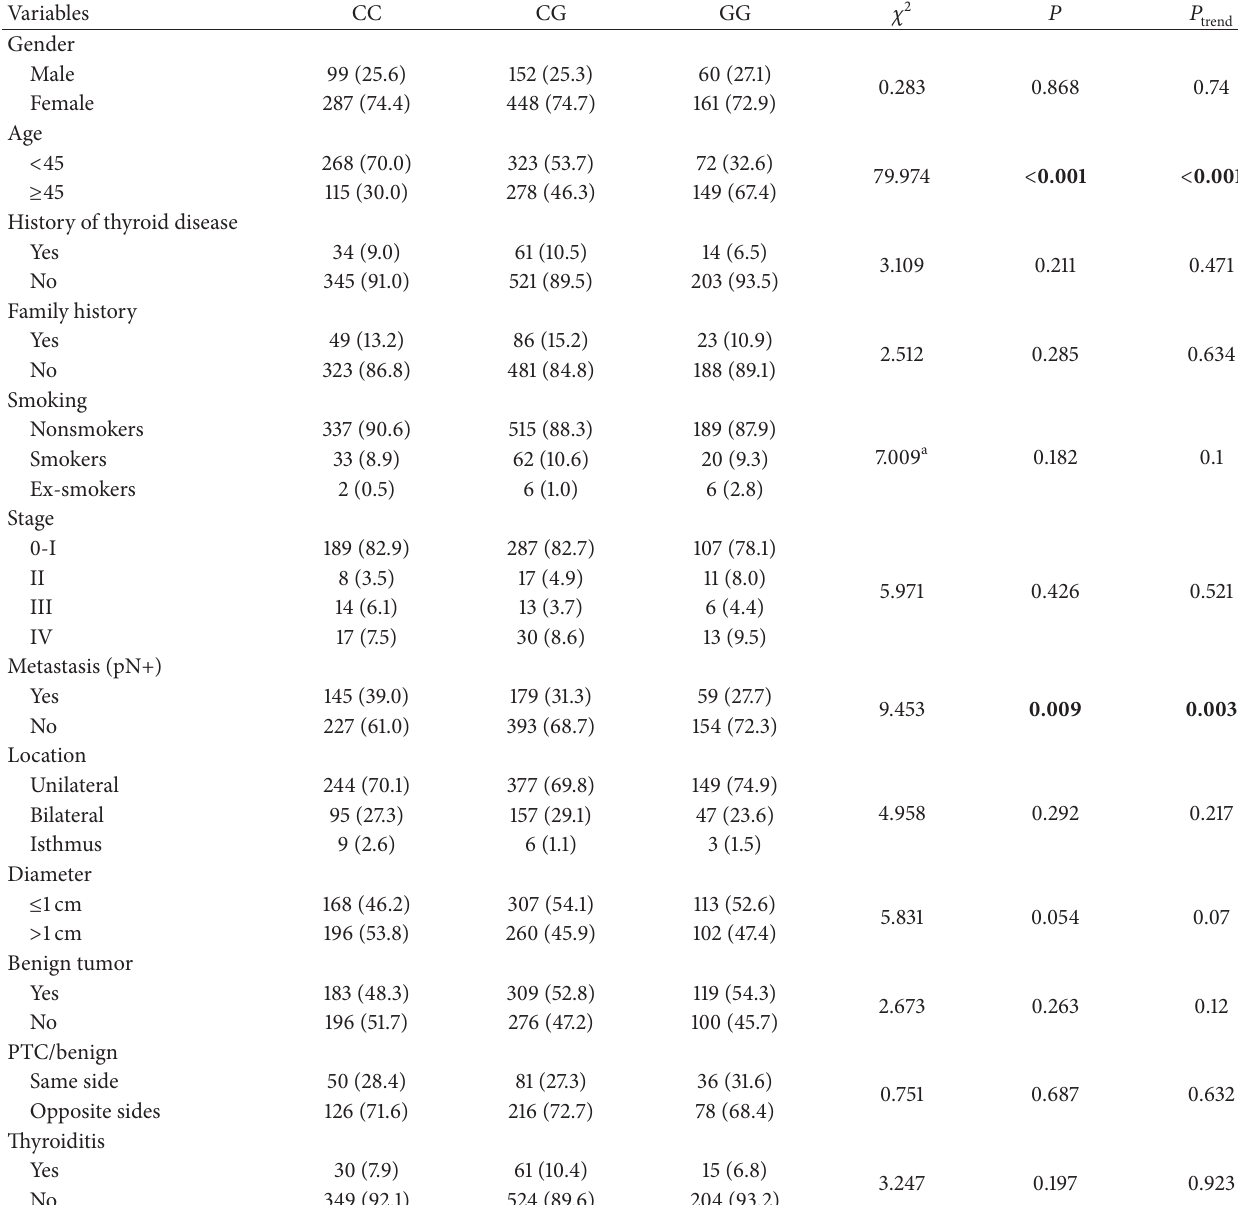
Table 4: The clinical characteristics of the PTC cases by rs2910164